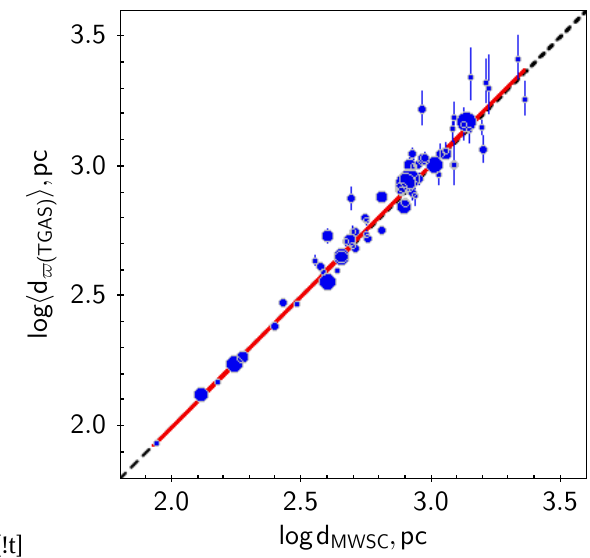
Figure 4. Logarithm of average trigonometric distance of a cluster log ⟨ d obtained from individual parallaxes of cluster members, TGAS ⟩ vs logarithm of photometric distances log d . While averaging MWSC trigonometric distances, MWSC members out of 3 σ from the mean TGAS distance were discarded from further consideration. 65 clus- ters with >16 members for parallax averaging after this procedure, are shown. The size of the circles is proportional to the number of TGAS parallaxes used for the average calculation; vertical bars rep- resent the errors of the mean TGAS distance. The black dashed line is a bisector, the red line represents the linear regression of the